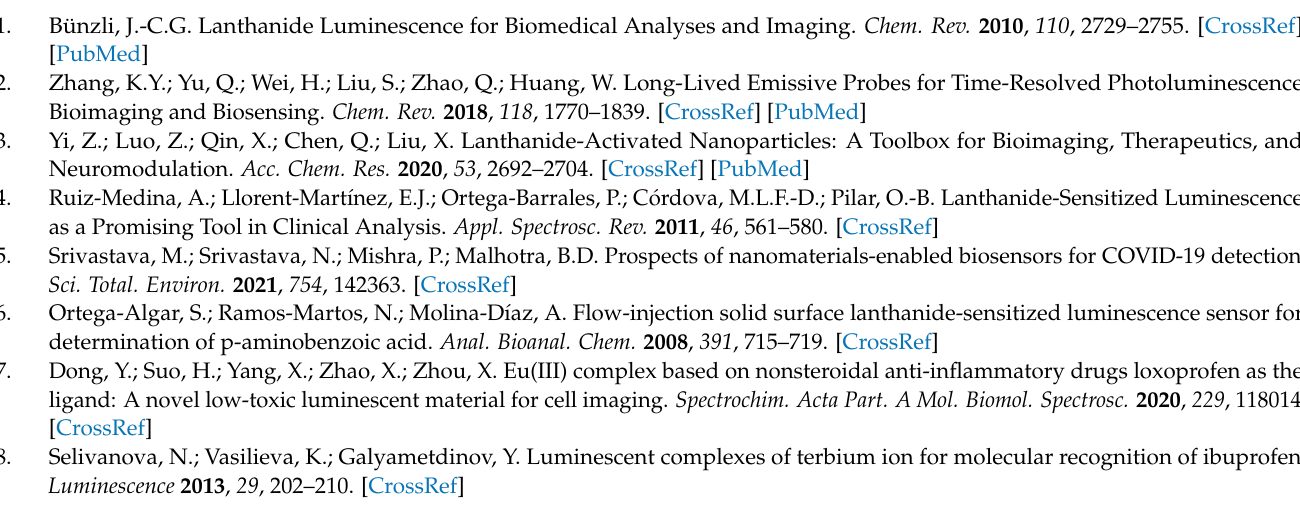
Figure S2: Fluorescence decay curve of Tb(Phen) in aqueous